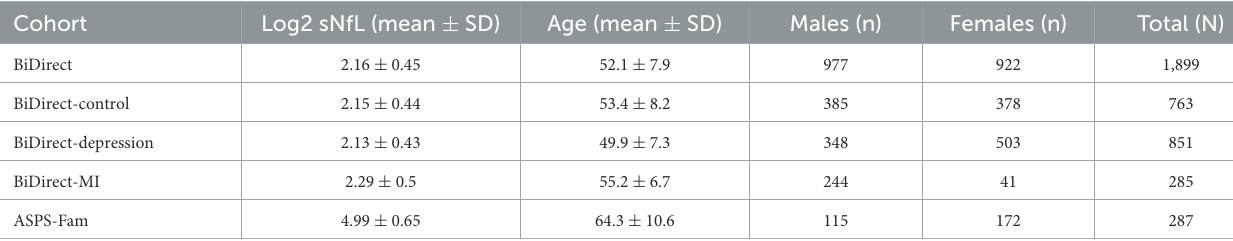
TABLE 1 Basic description of BiDirect and ASPS-Fam